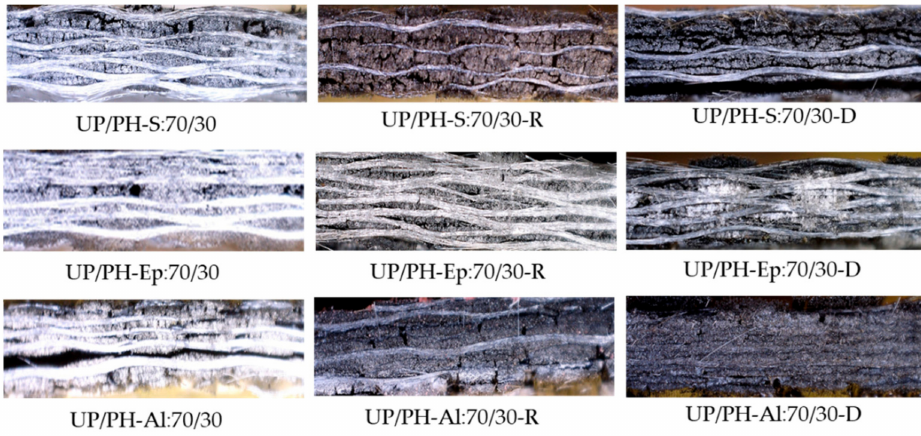
Figure 3. Digital microscopic images of GFRC samples after cone